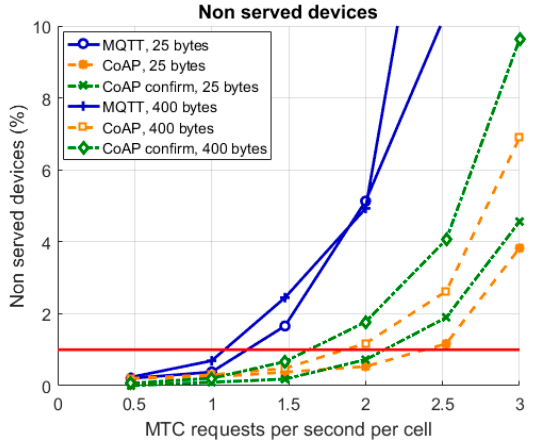
Figure 3. Percentage of non-served devices as a function of load.